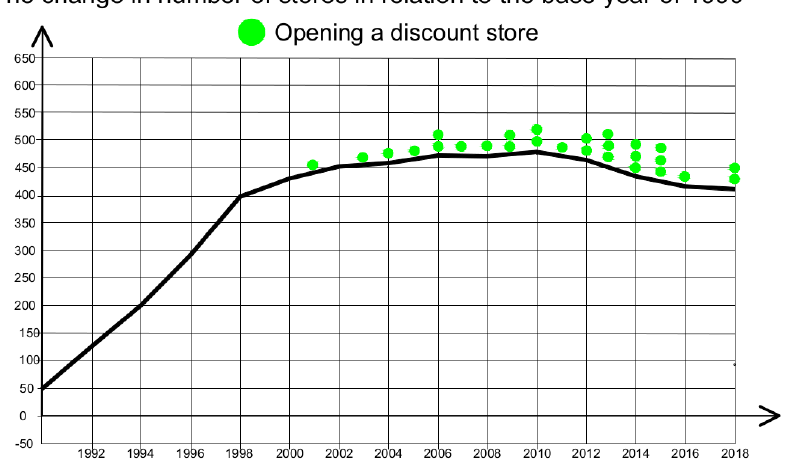
Figure 5. The change in number of stores in relation to the base year of 1990 in analyzed towns.